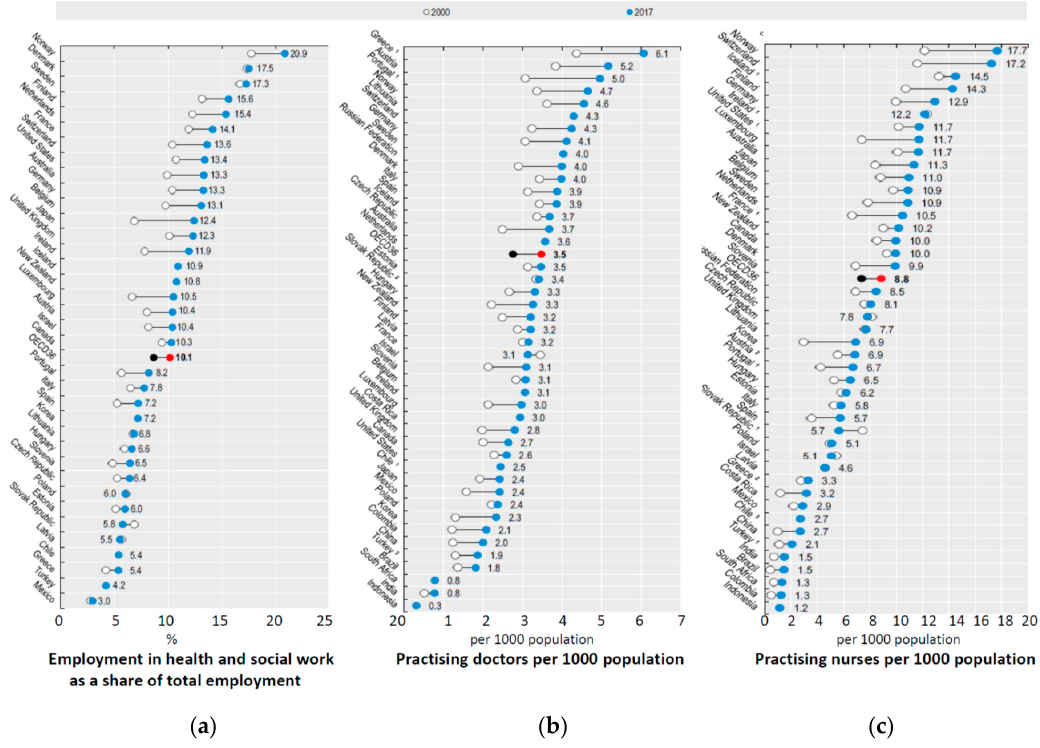
Figure 27. Changes in the years 2000–2017: ( a ) employment in health and social work as a share of total employment, ( b ) practising doctors per 1000 population, ( c ) practising nurses per 1000 population.